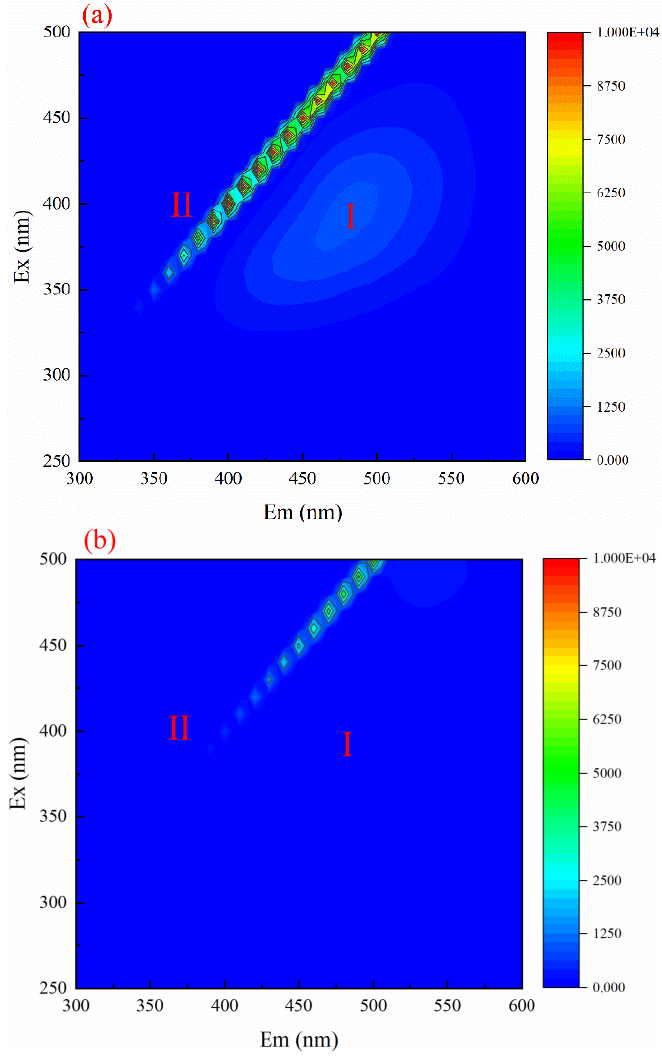
Figure 6. The 3D fluorescence spectra of coal chemical wastewater under different conditions: ( a ) before treatment; ( b ) after processing.